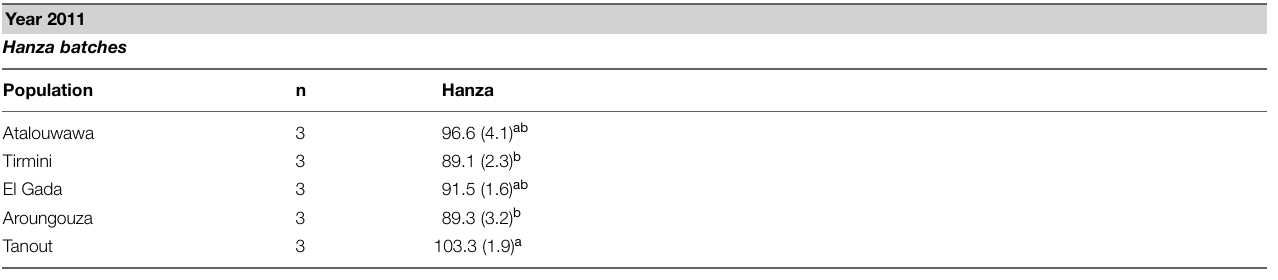
TABLE 1 | Average concentration ( µ moles.g − 1 dry mass; SEM between brackets) of methylglucosinolate (MeGSL) in different organs of Boscia sengalensis in different years and populations in Niger,